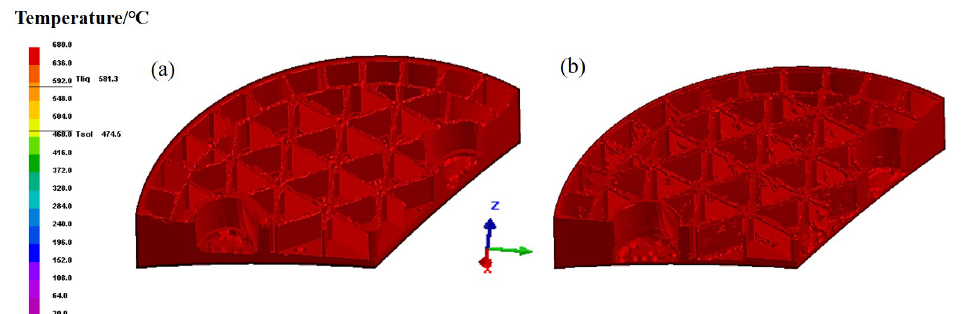
Figure 6. Temperature distribution in the filling process. ( a ) 38.56 s, ( b ) 38.91